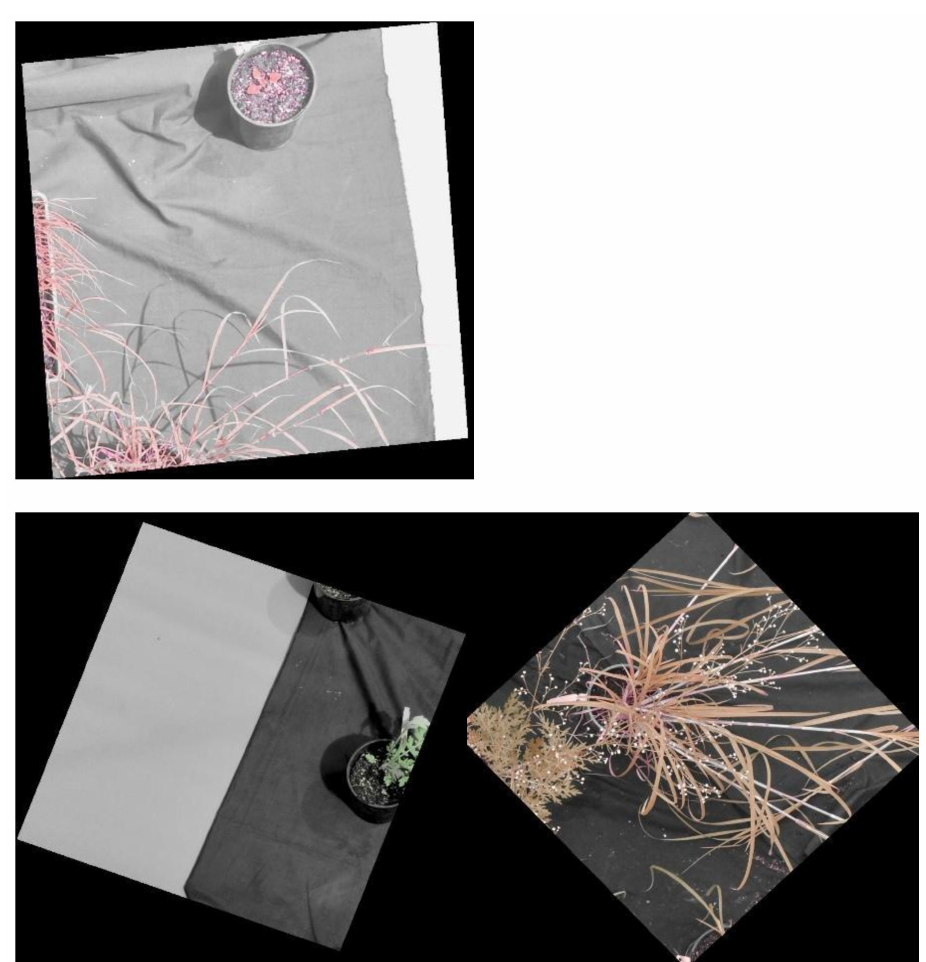
Figure 3. Examples of augmented images with all augmentation types applied randomly within preset bounds.